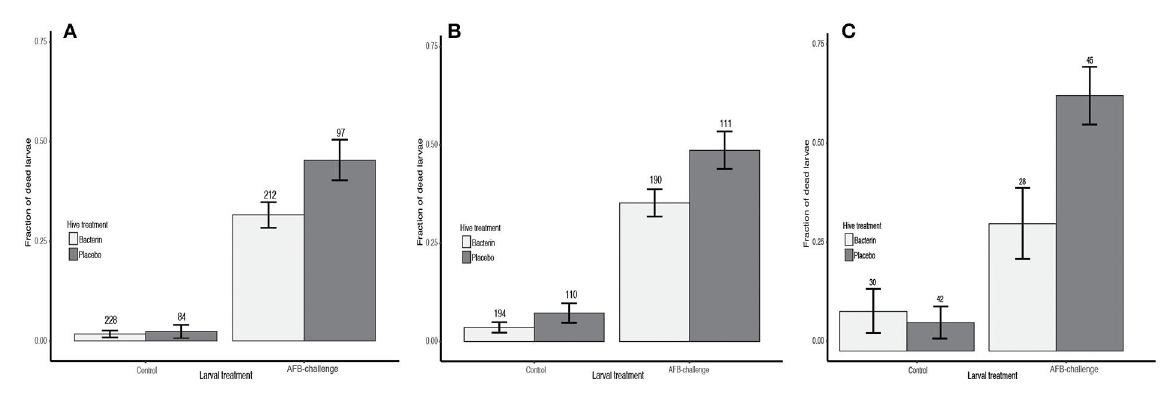
FIGURE1 The efficacy of the vaccination to prevent the infection with AFB. Prevented Fraction showing the vaccination efficacy of P. larvae bacterin (light grey bars) vs. Placebo (dark grey bars) in a heterologous challenge, as mortality of larvae after 8 days. (A) Study Site A—first challenge, (B) Study Site A—second challenge, and (C) Study Site B—second